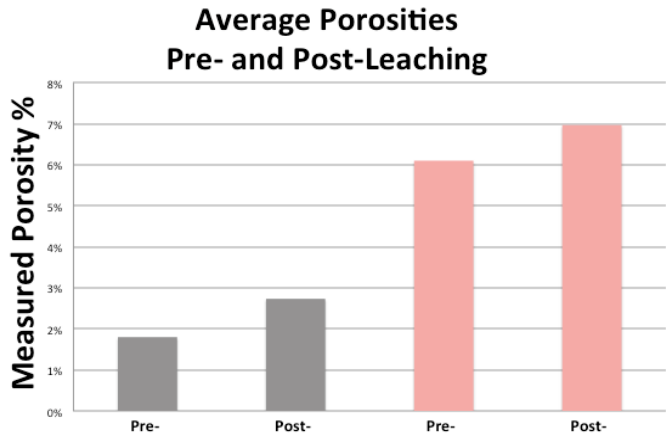
Figure 6. Average (15 samples per color) porosity pre- and post-leaching, showing an increase in porosity after sulfuric acid dissolution. Gray bars represent gray samples; red bars represent pink samples.